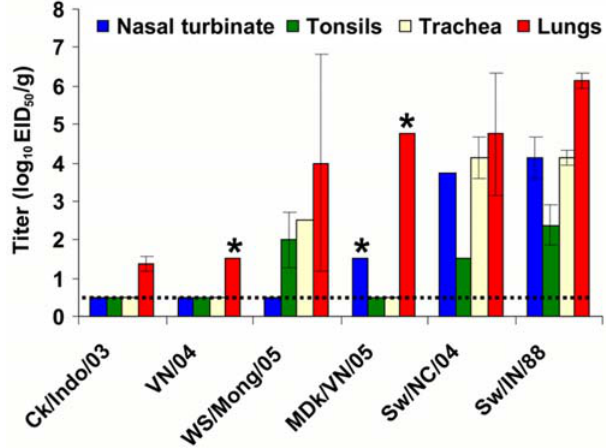
Figure4.Virus titer in pig tissues onday 5 after virus inoculation. Each data point represents the mean and range virus titer ( log 10 EID 50 / gram of tissue ) from two pigs. The lower virus detection limit is 10 0.5 EID 50 /g. *-virus was detected in organs of one pig.